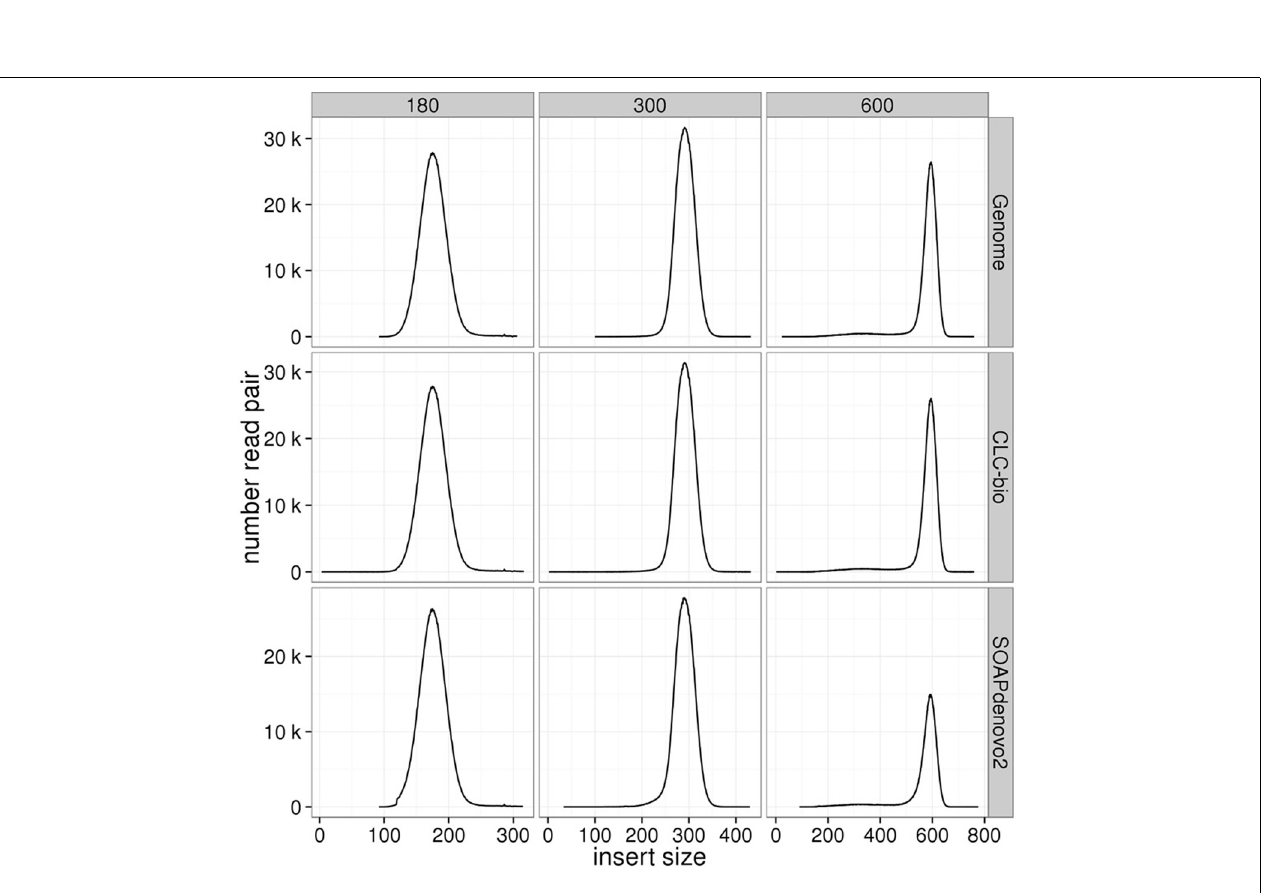
FIGURE 3 | Estimation of insert sizes for E. coli paired-end genomic libraries. Insert sizes are plotted for each target size using reads mapped against the E. coli reference genome, CLC, and SOAPdenovo2 assemblies.